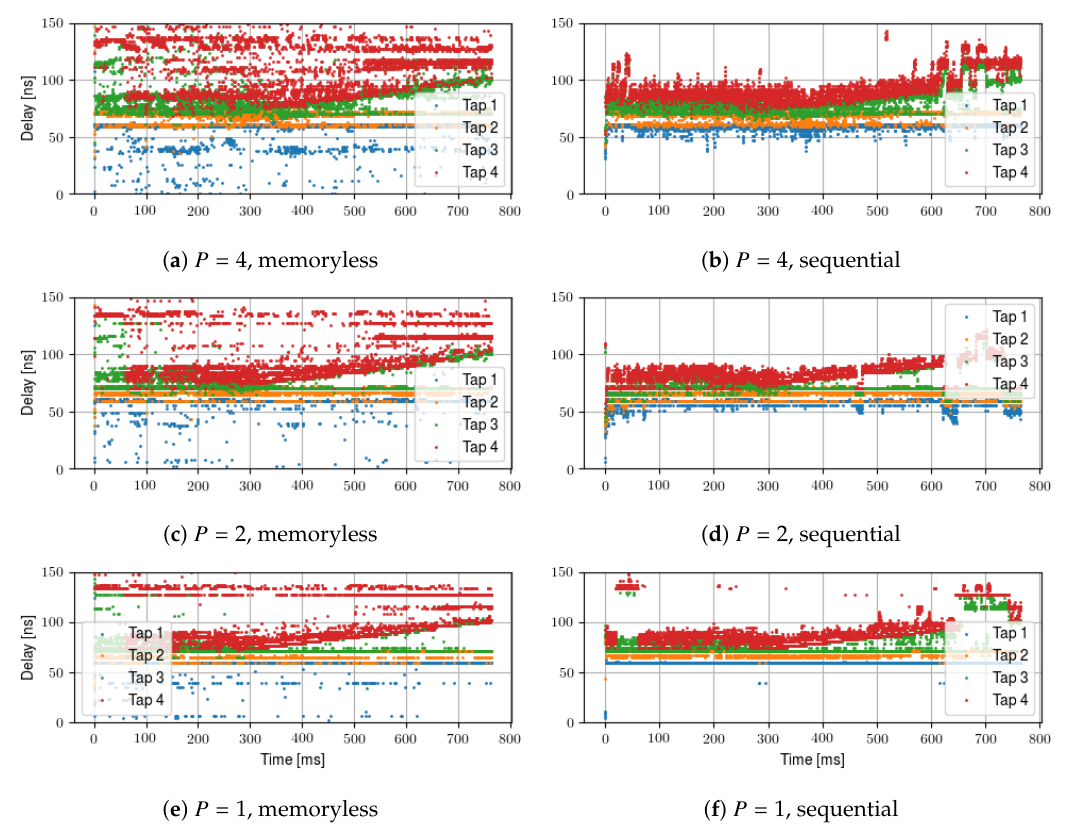
Figure 9. Four-tap delay evolution for an overtaking SUV: memoryless estimations ( a , c , e ); and sequential estimations ( b , d , f ). The figure shows that spatial consistency is preserved well using sequential